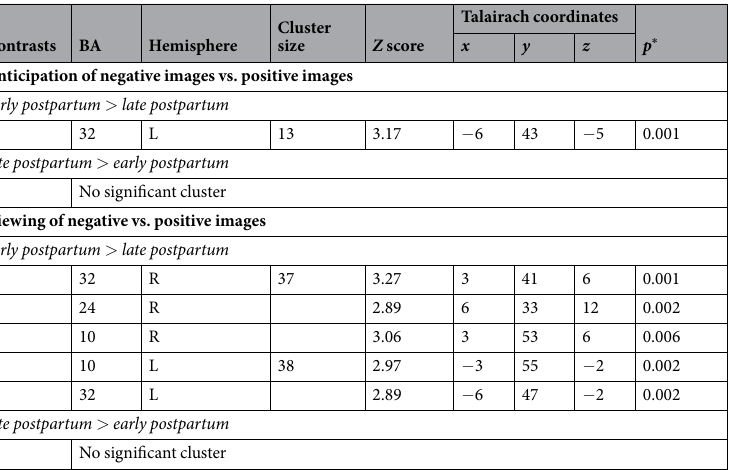
Talairach coordinates Cluster Contrasts BA Hemisphere size Z score p * x y z Anticipation of negative images vs. positive images 32 L 13 3.17 − 6 − 5 0.001